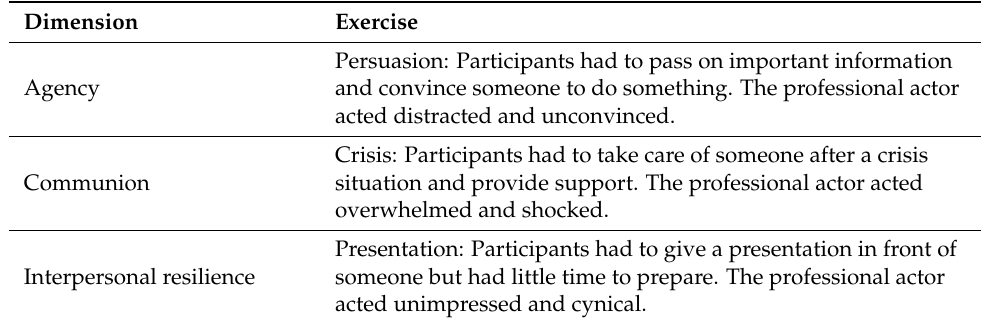
Table 2. Overview of Skill Dimensions and Exercises.